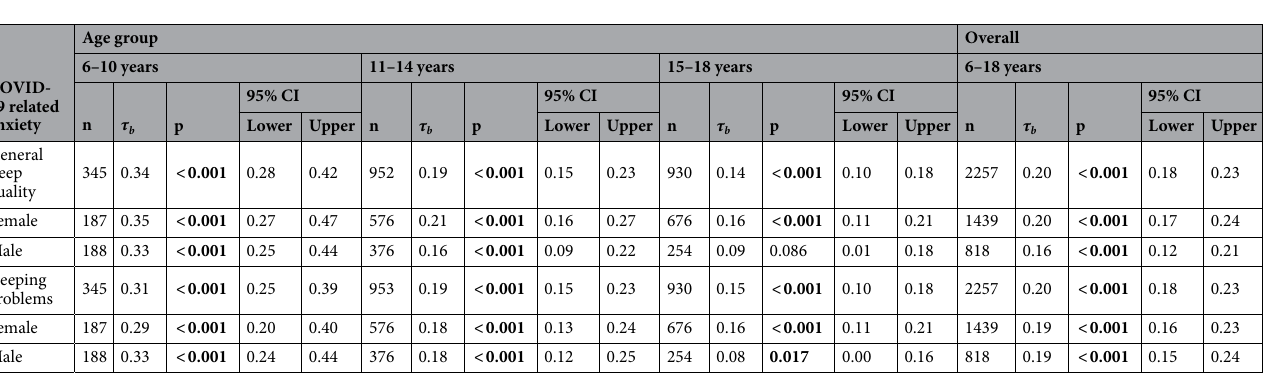
Table 2. Correlation coefficients (Kendall’s Tau, τ b ) for COVID-19 related anxiety and general sleep quality as well as sleeping problems during COVID-19. τb 0.07–0.19 small effect; τb 0.20–0.33 medium effect;